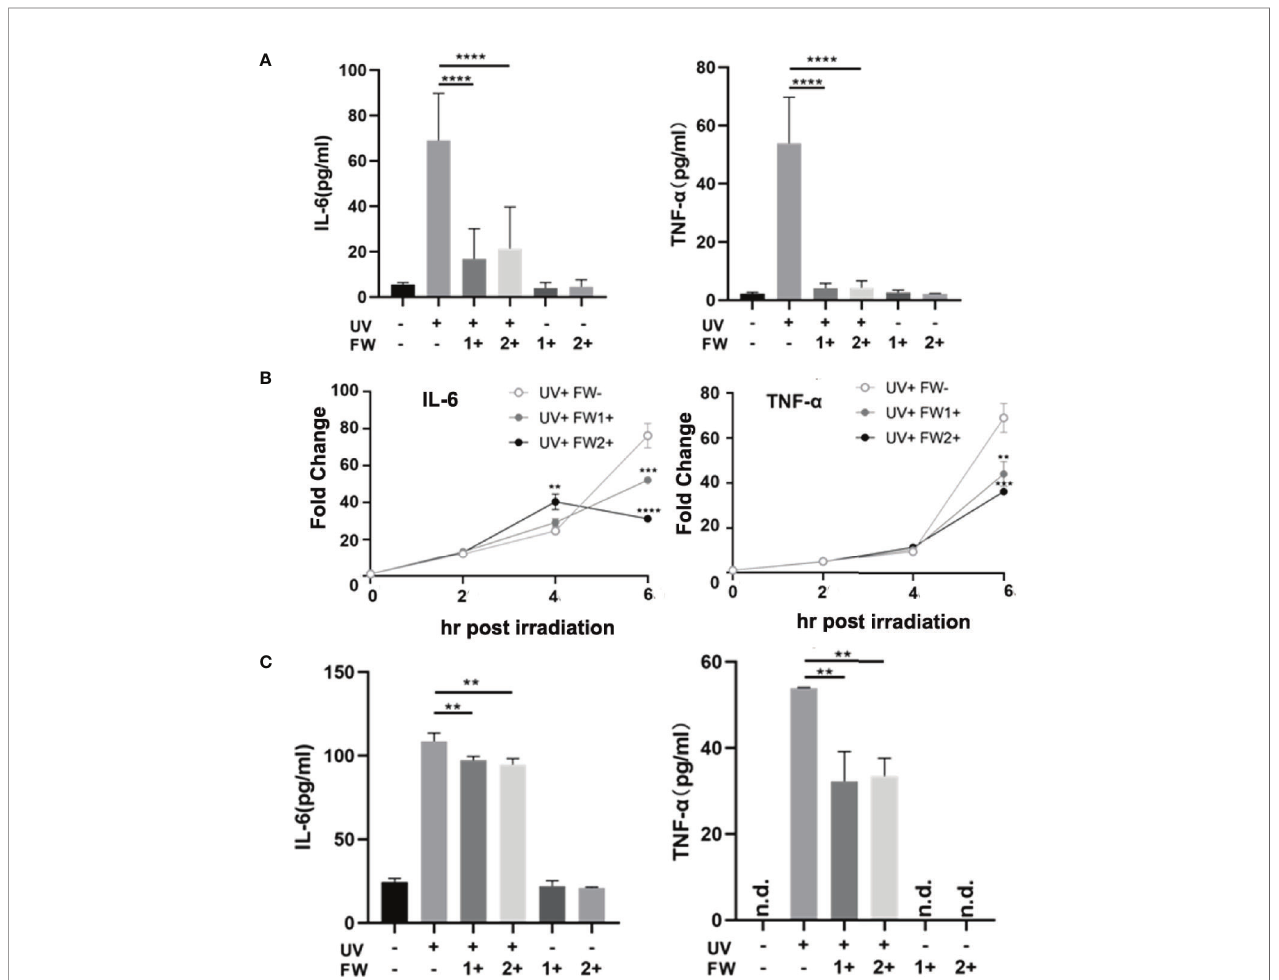
FIGURE 4 | FW-1 and -2 suppress the expression of in fl ammatory cytokines in UV-irradiated keratinocytes. (A) Skin tissues of mice with or without FW-1 and -2 treatment (5 mg/kg) were obtained after 48 hr post UV exposure (500 mJ/cm 2 UVB). Mouse IL-6 and TNF- a expression level were determined by ELISA (n=5). ****P < 0.0001. HaCaT cells with or without FW-1 and -2 (12 m g/ml) pre-treatment were exposed to UV irradiation (10 mJ/cm 2 ). After 6 hr, levels of mRNA (B) and secreted protein (C) for TNF- a and IL-6 were measured by QRT-PCR and by ELISA, respectively. (n=3). Error bars represents mean ± S.D. **P < 0.01, ***P < 0.001, ****P <